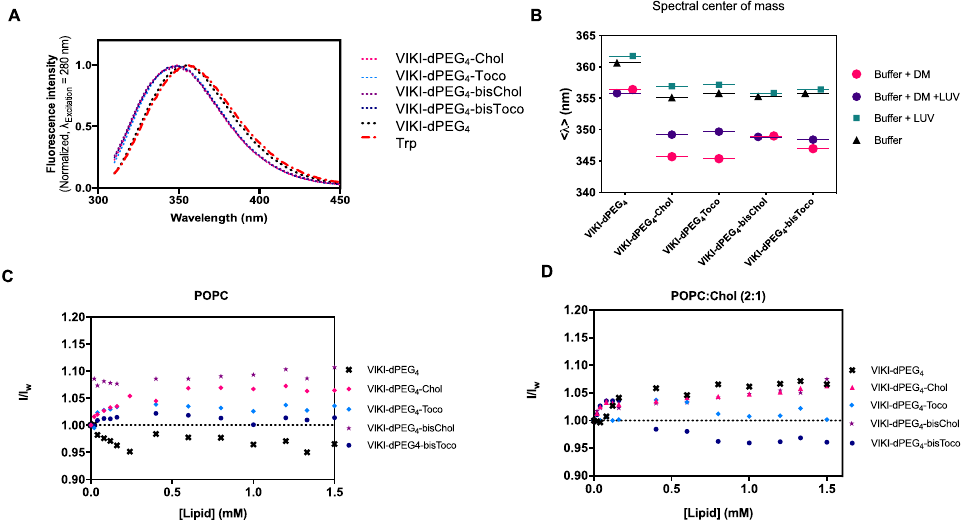
Figure 1. ( A ) Normalized fluorescence excitation spectra of 5 μM VIKI-dPEG 4 , VIKI-dPEG 4 -Chol, VIKI-dPEG 4 -Toco, VIKI-dPEG 4 -bisChol, VIKI-dPEG4-bisToco, and tryptophan in HEPES buffer with 1% DMSO. ( B ) Spectral center of mass (see Equation (2)) of the fluorescence emission variations shown for the VIKI peptides solubilized in DM detergent (circles) in the presence or absence of POPC vesicles (LUV). Peptide-DM monomers and peptide-POPC vesicles interactions can be measured by finding the spectral center of mass of the fluorescence emission. Partition of the fusion inhibitors peptides to POPC ( C ), and ( D ) POPC:Chol (2:1) LUV. All data resulted from mean values from at least three independent experiments.